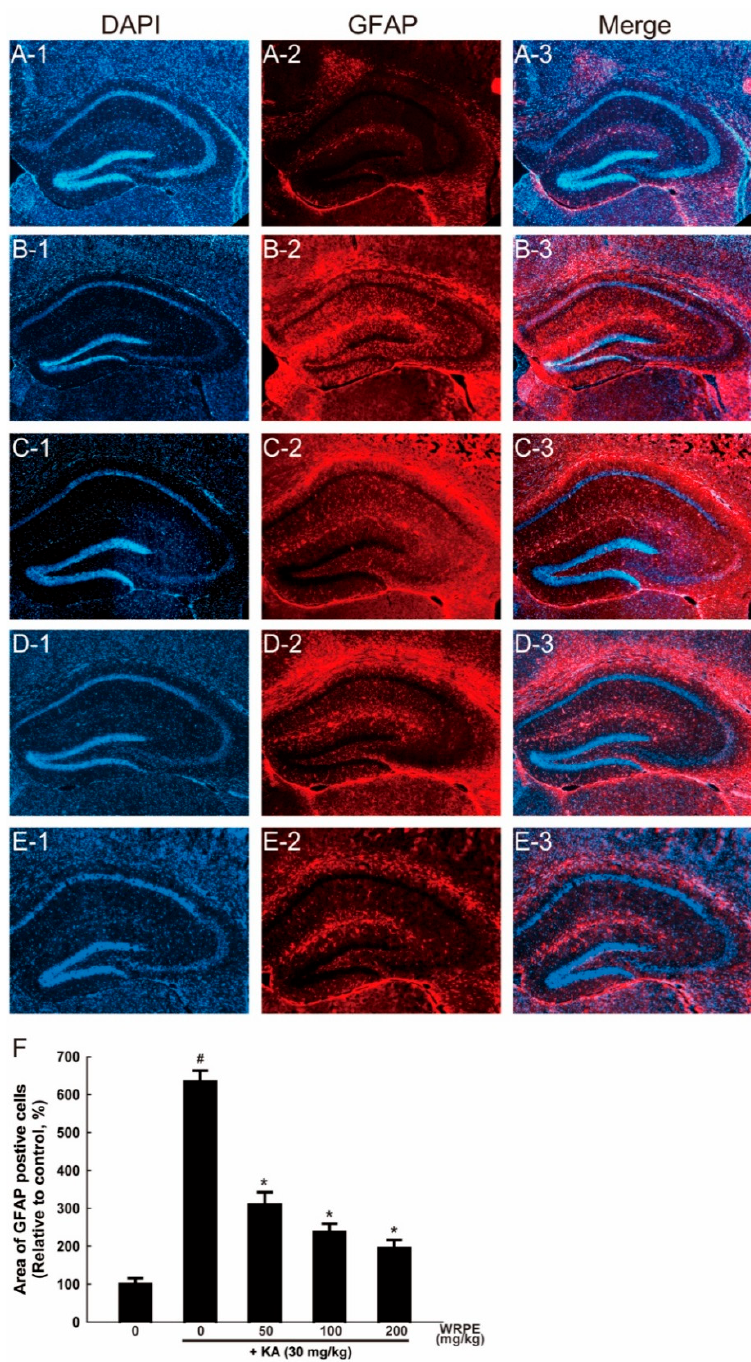
Figure 8. Neuroprotective activity of white rose petal extract (WRPE) in kainic acid (KA)-challenged mice observed by glial fibrillary acidic protein (GFAP) (red-colored) immunostaining, showing representative microscopic findings ( A – E ) and the number of activated (GFAP-positive) astrocytes ( F ). ( A ) Normal (vehicle) control, ( B ) KA (30 mg/kg) alone, ( C ) KA + WRPE (50 mg/kg), ( D ) KA + WRPE (100 mg/kg), and ( E ) KA + WRPE (200 mg/kg). ( F ) Relative quantification of GFAP-positive astrocytes in the brain coronal section. n = 3 per treatment group. # Significantly different from normal control ( p < 0.05). * Significantly different from vehicle control ( p < 0.05).